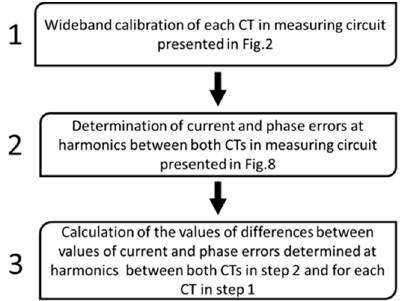
Figure 9. Flowchart of verification of results of the wideband self-calibration of inductive CT.